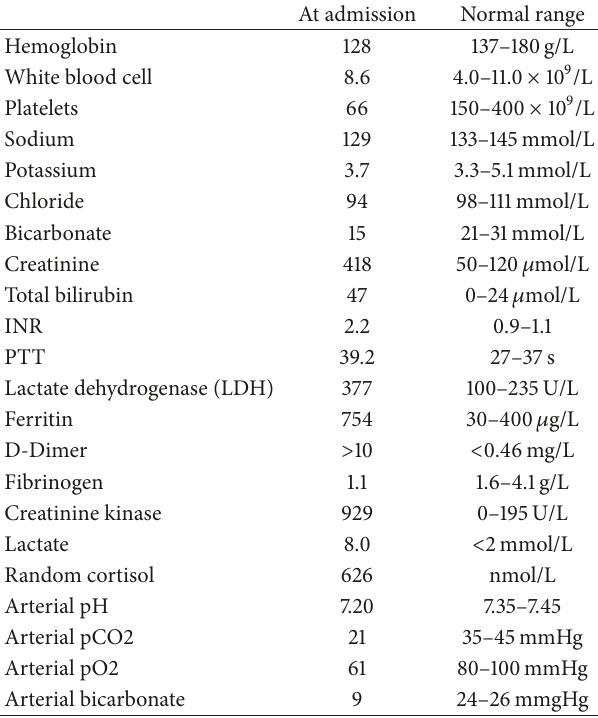
Table 1: Bloodwork on initial presentation to the emergency department.